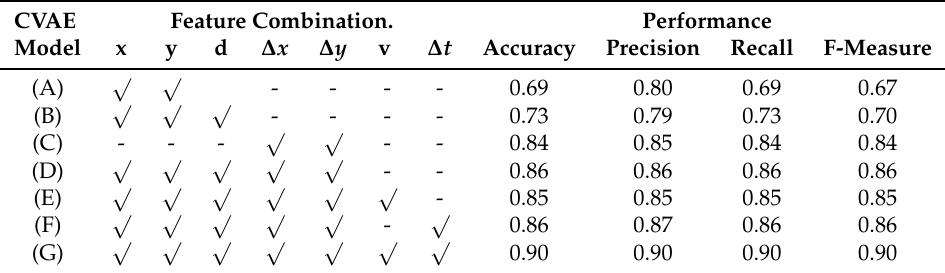
Table 5. Evaluation results for the CVAE model using different feature